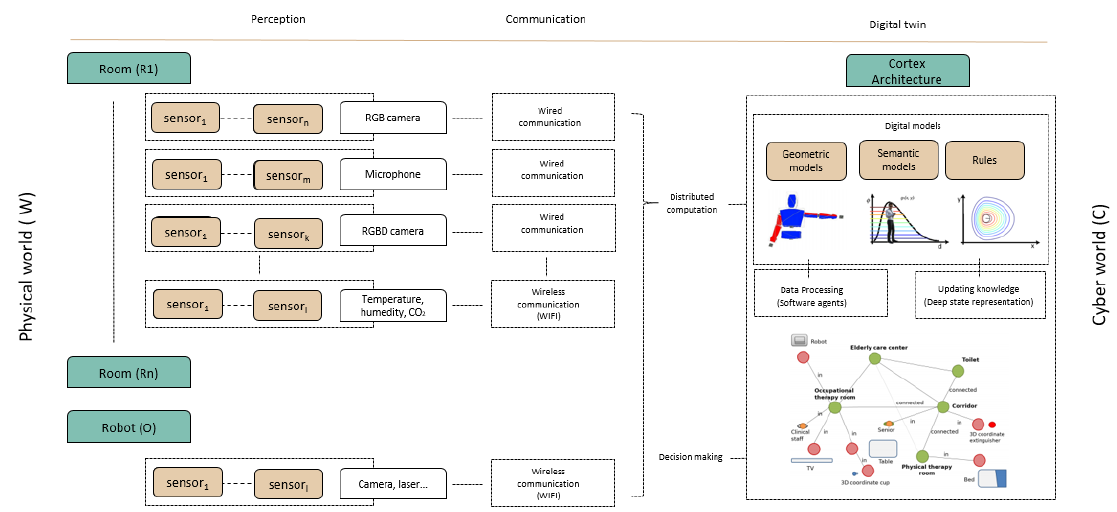
Figure 2. General view of the CPS-AAL